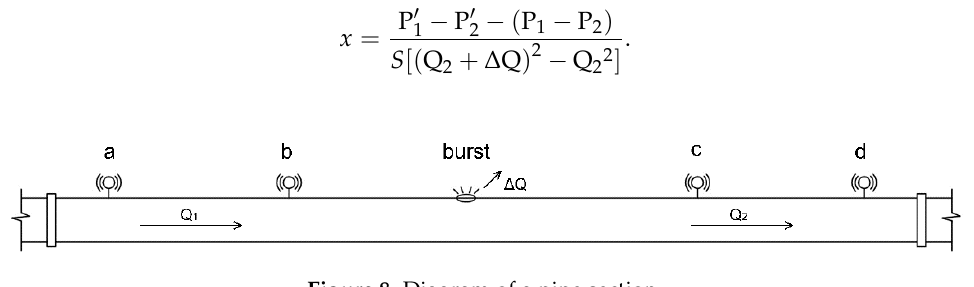
Figure 8. Diagram of a pipe section.